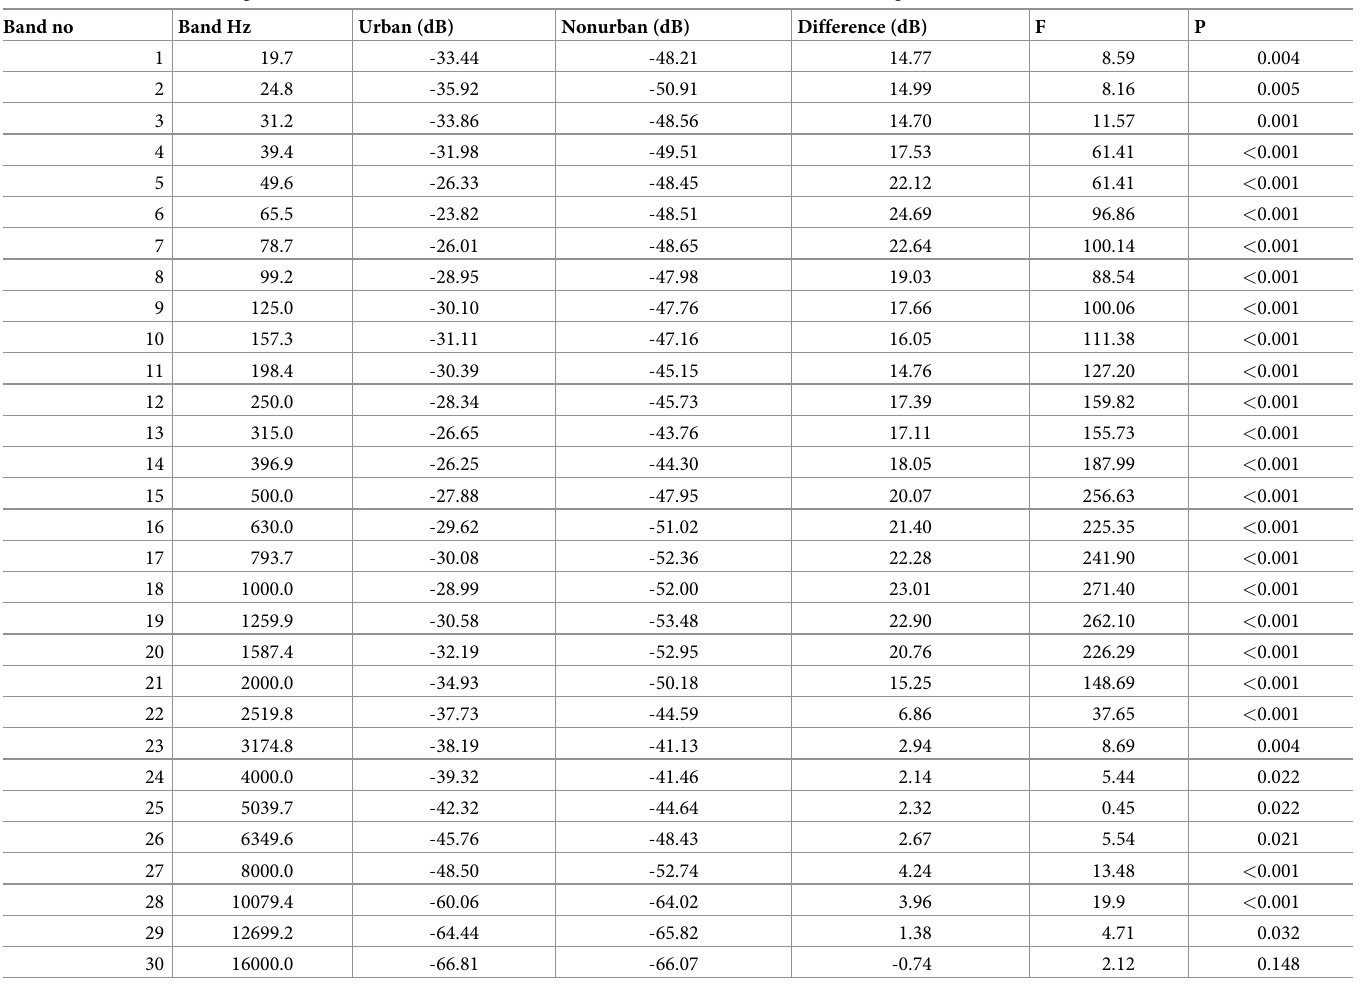
Table 1. Differences in average ambient noise levels between urban (n = 44) and nonurban (n = 58) recording